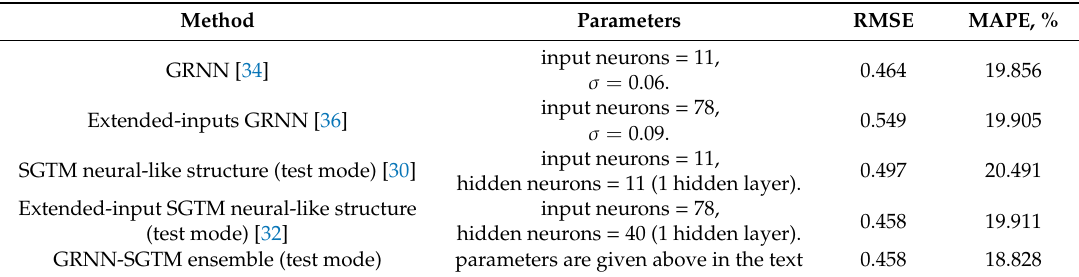
Table 4. Comparison of operation accuracy of all the methods